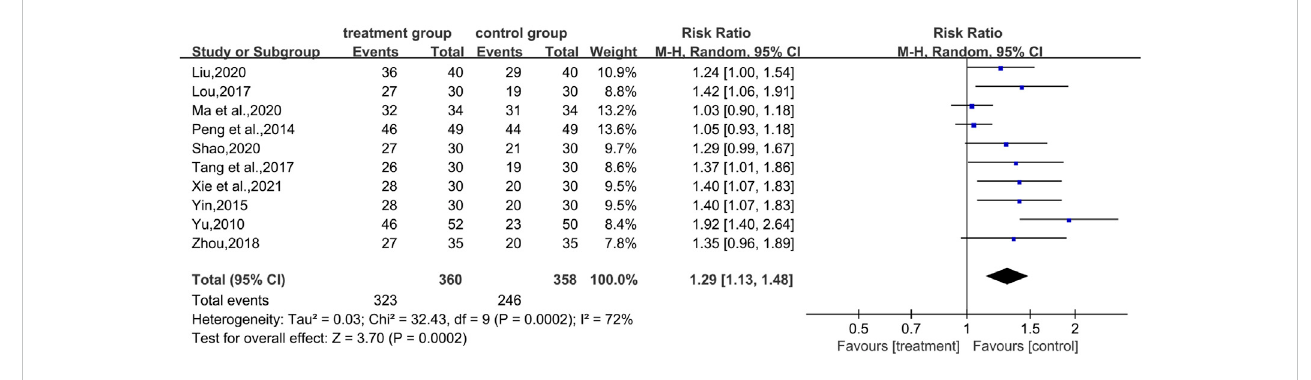
FIGURE 7 Forest plot for overall effective rate.